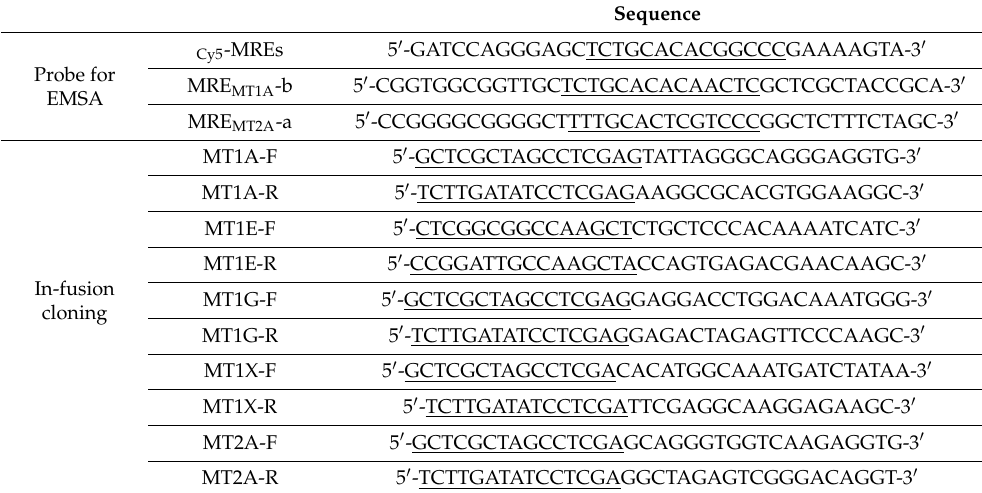
Table 1. Oligo DNA sequence used for EMSA and